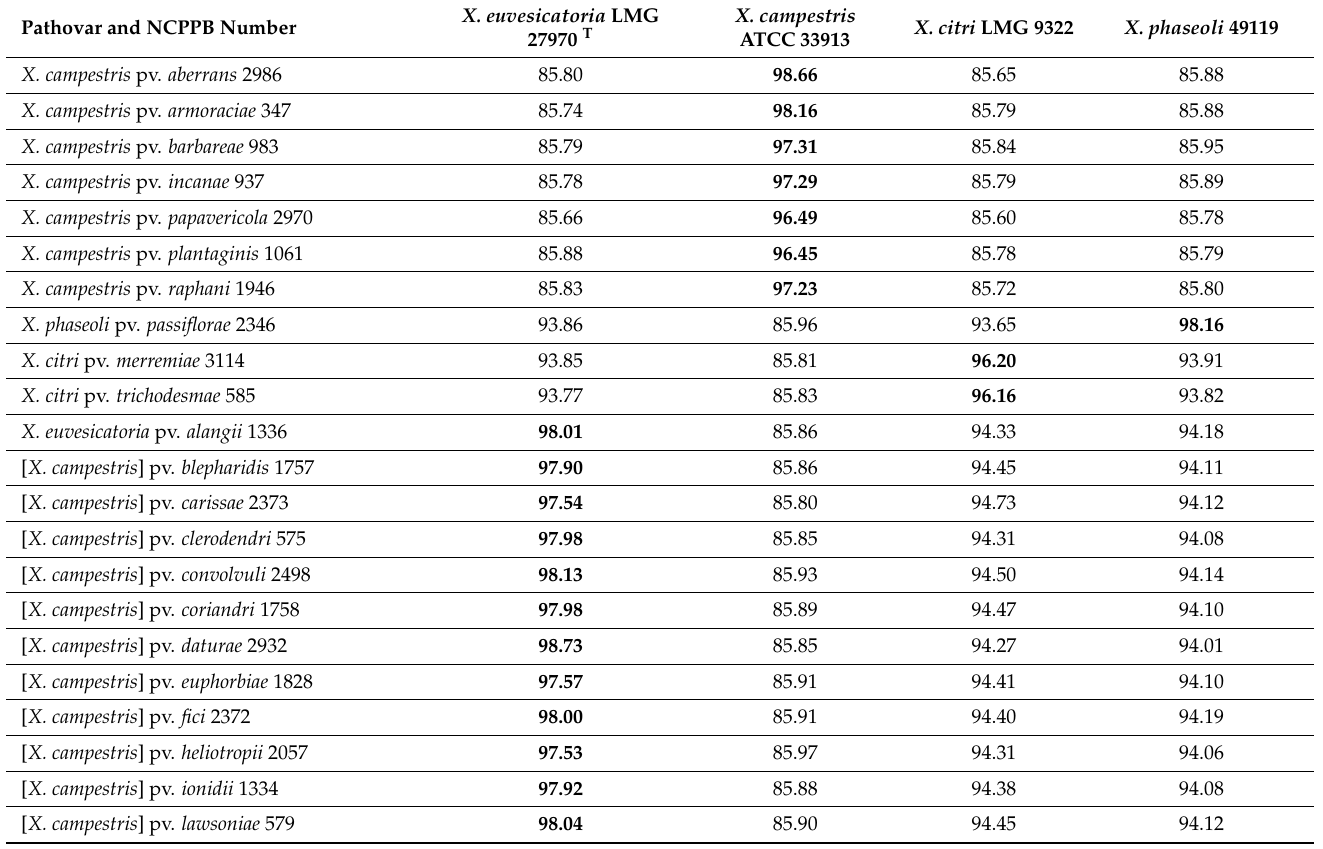
Table 3. Percentage average nucleotide identities (ANI) between genomes of the newly sequenced X. campestris pathotype strains versus genomes of type strains of X. campestris , X. citri and X. euvesica- toria [10,62,63]. Values of ANI exceeding 96% are highlighted in